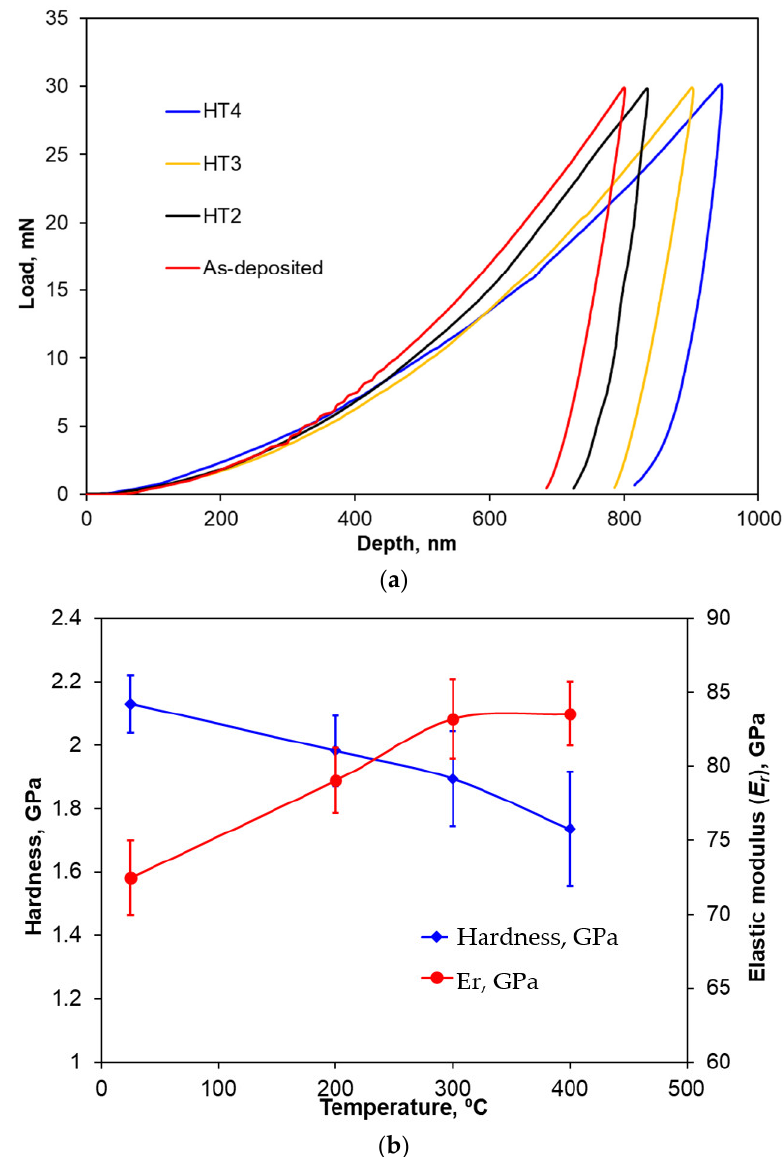
Figure 5. ( a ) The load–displacement curves and ( b ) the hardness and modulus of the as-deposited and heat-treated AA7075 coating obtained via nanoindentation